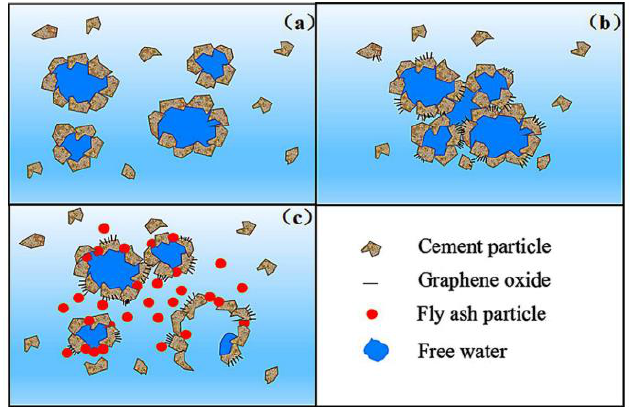
Figure 5. Schematic diagram of the formation of flocculation structure. ( a ) Cement paste, ( b ) GO reinforced cement paste; ( c ) GO reinforced cement paste with fly ash. Reprinted with permission from Ref. [61]. Copyright 2017 Elsevier.